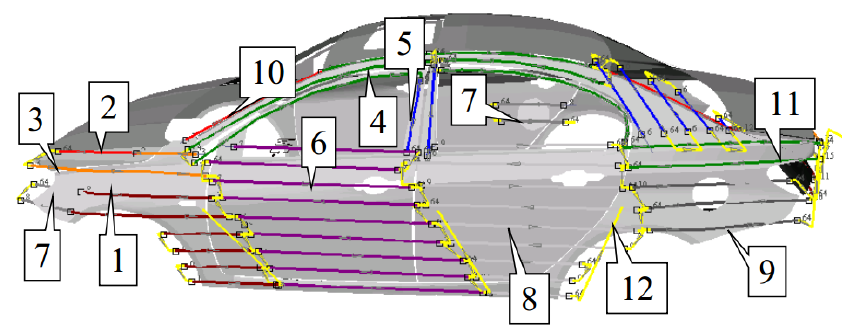
Figure 9. Optimized trajectory of the roof.